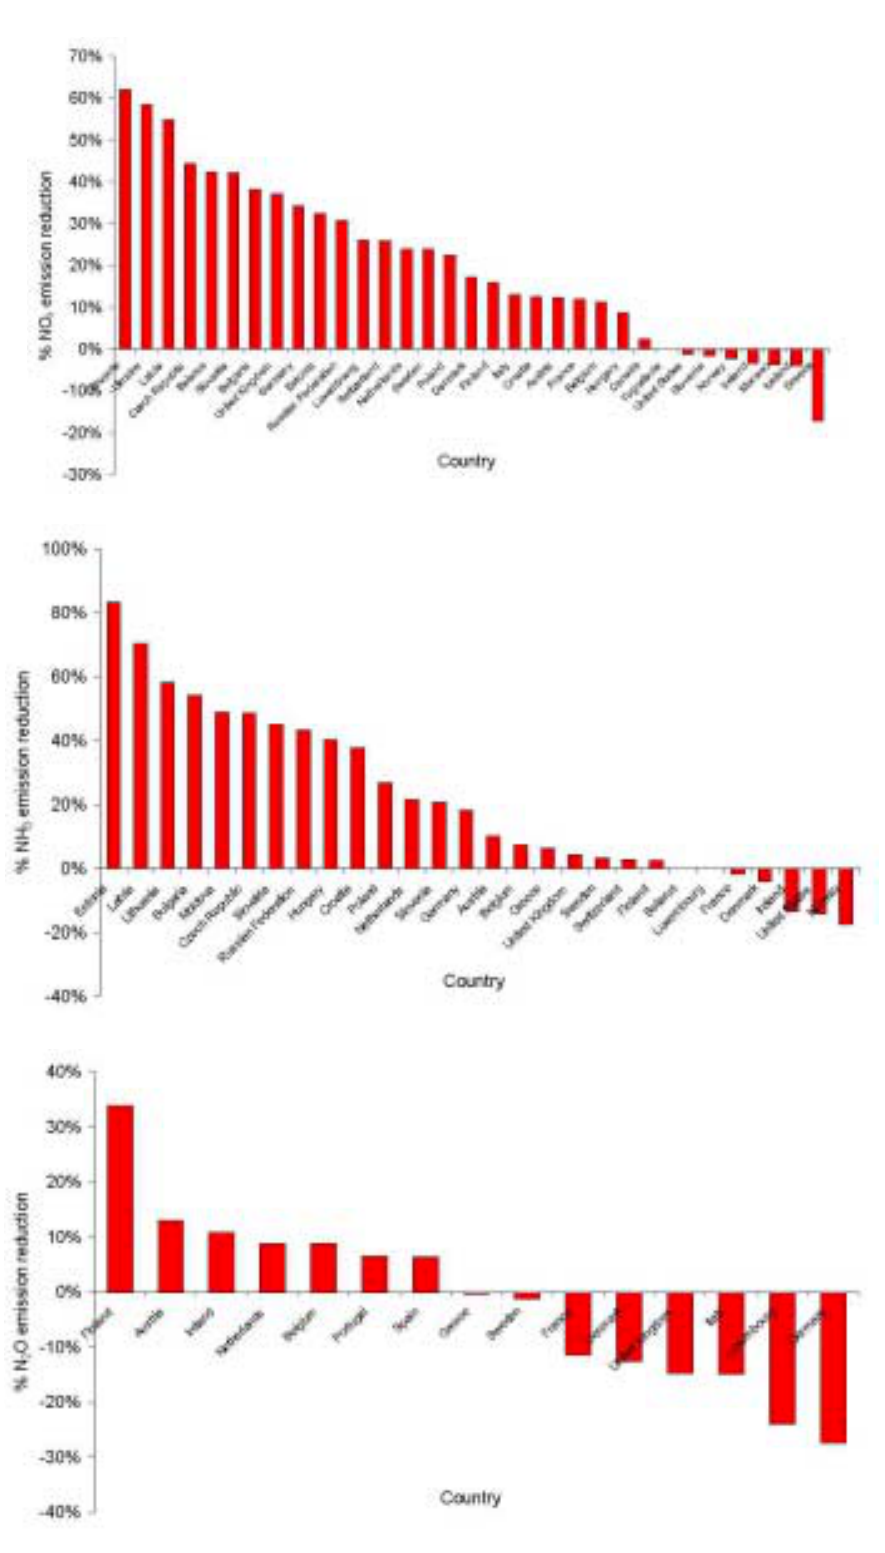
FIGURE 3. Changes in emissions (%) between 1990 and 1998 for NO x (A), NH 3 (B) and N 2 O (C). (Data from